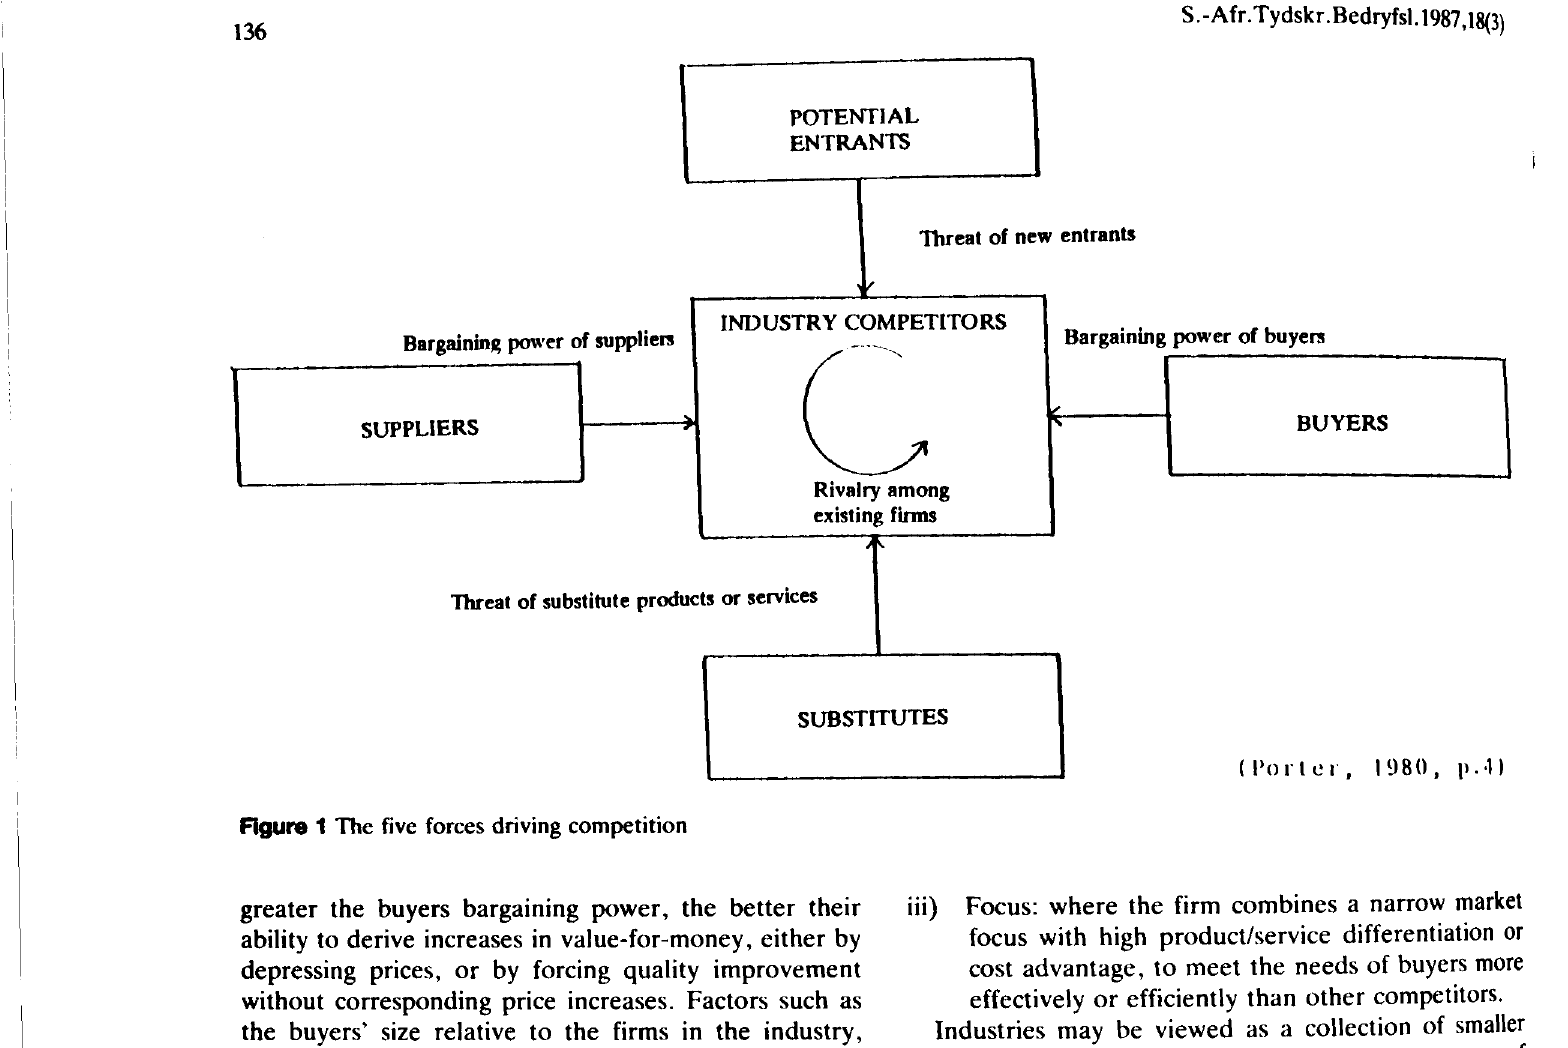
Figure 1 The five forces driving competition